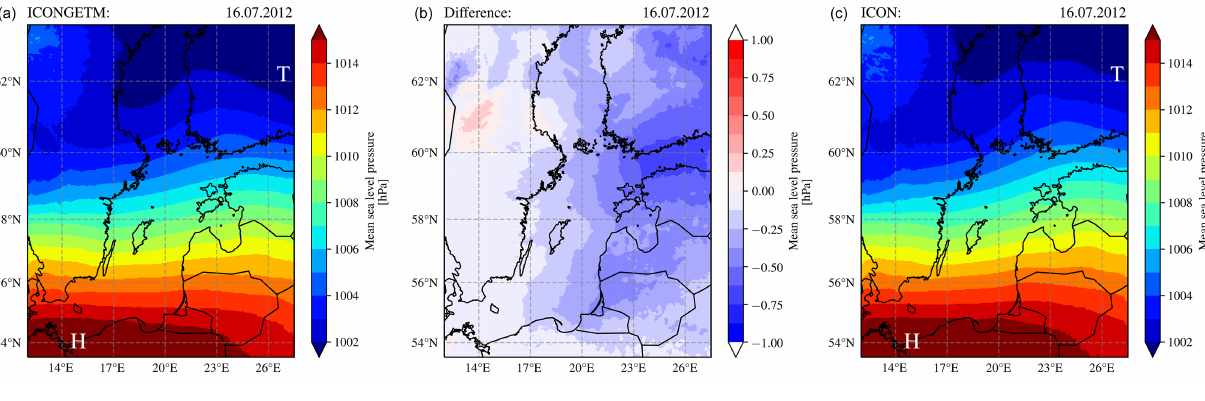
Figure 10. Daily mean sea level pressure from the two-way coupled ICONGETM simulation (a) and the uncoupled/one-way coupled ICON simulation (c) as well as the difference ICONGETM minus ICON (b) for 16 July 2012. “T” and “H” mark surface lows and highs,